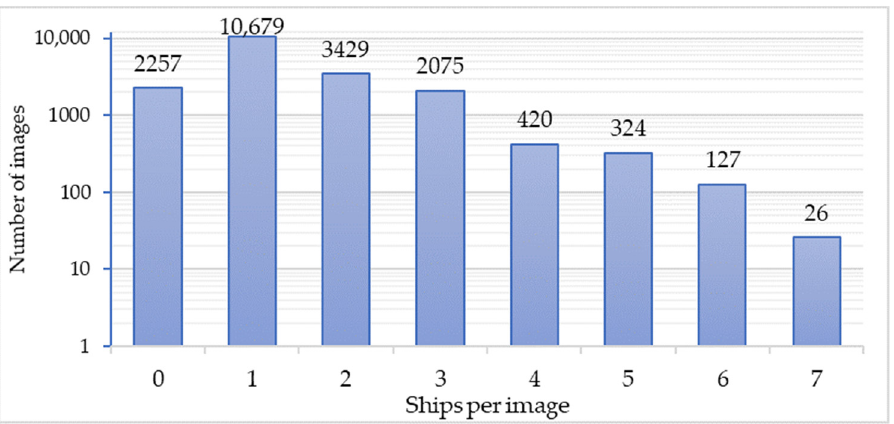
Figure 6. Histogram of the distribution of the number of ships per image.